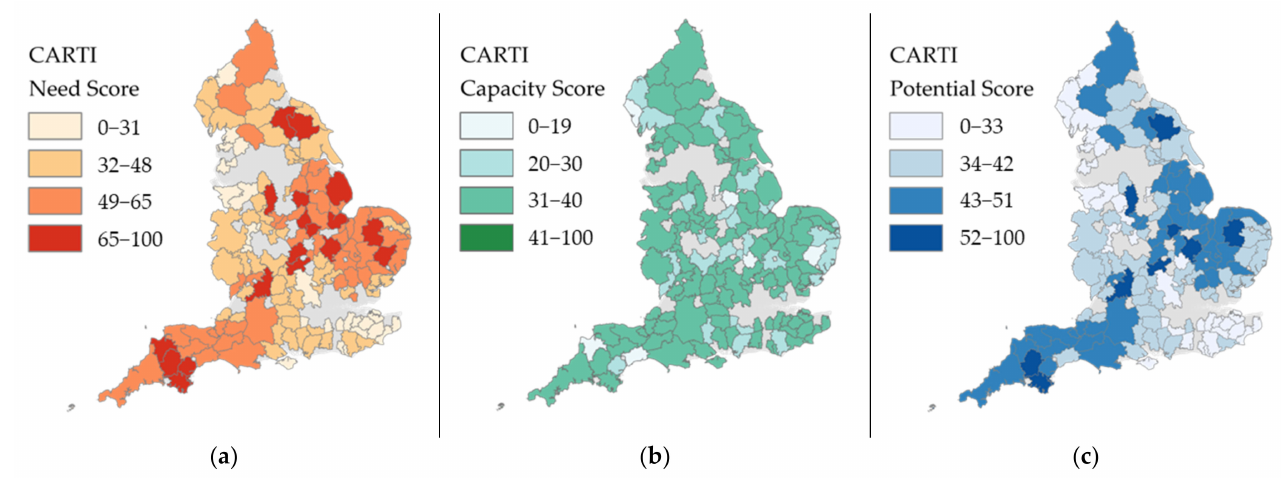
Figure 2. CARTI results. ( a ) Need Score, ( b ) Capacity Score, ( c ) Potential Score.